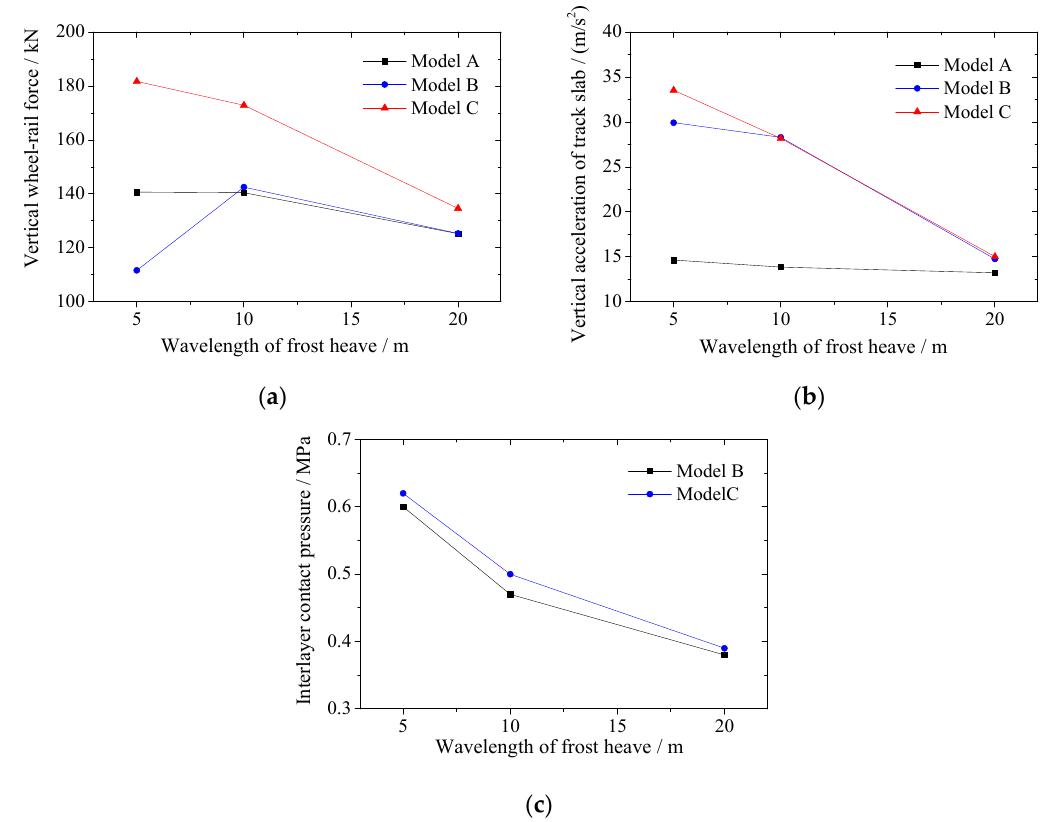
Figure 17. Typical dynamic response of different models under different wavelengths. ( a ) Maximum vertical wheel-rail force; ( b ) Maximum vertical acceleration of track slab; ( c ) Maximum vertical interlayer contact pressure.